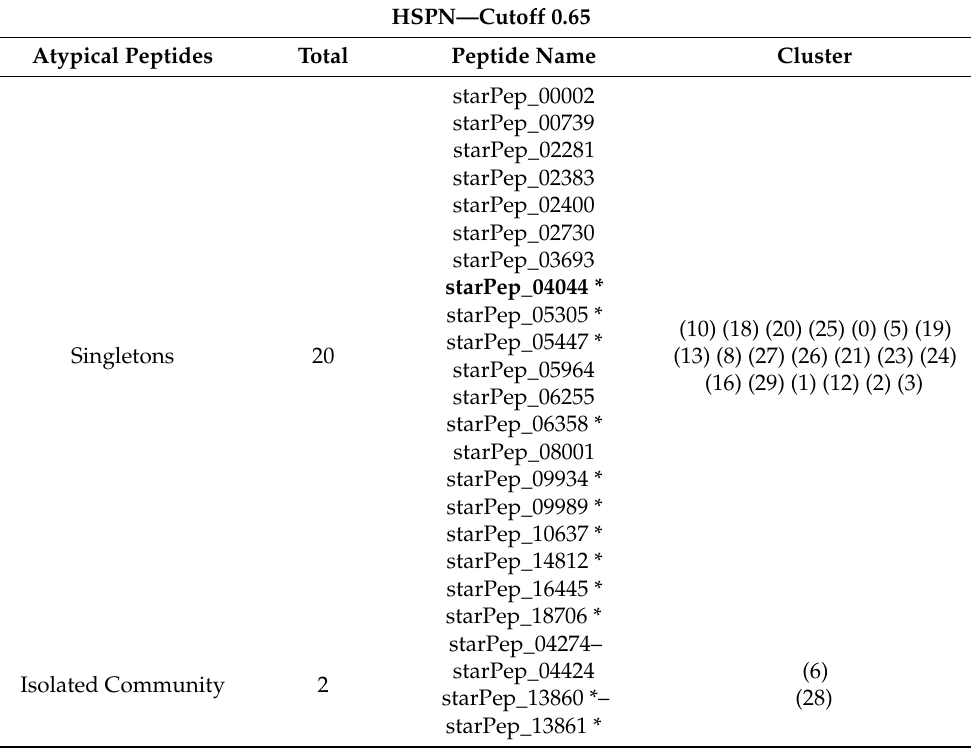
Table 2. Atypical peptides identified by the HSPN at a similarity cutoff of 0.65. Particularly, the singletons and isolated communities made up of two peptides are